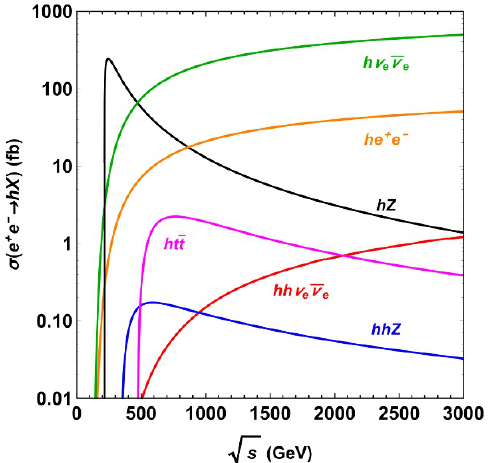
Figure 6 . Cross section as a function of CM energy for dominant Higgs production processes in the SM at e + e (cid:0) colliders with m h = 125 GeV.